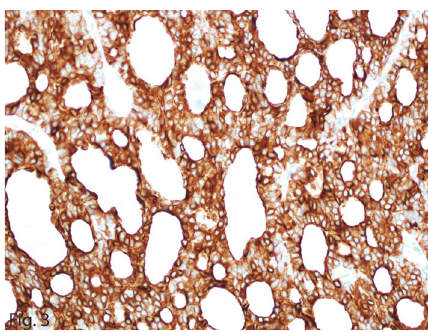
Figure 3: Cytokeratin 7 immunostain in the neoplastic cells (origi- nal magnification × 40).